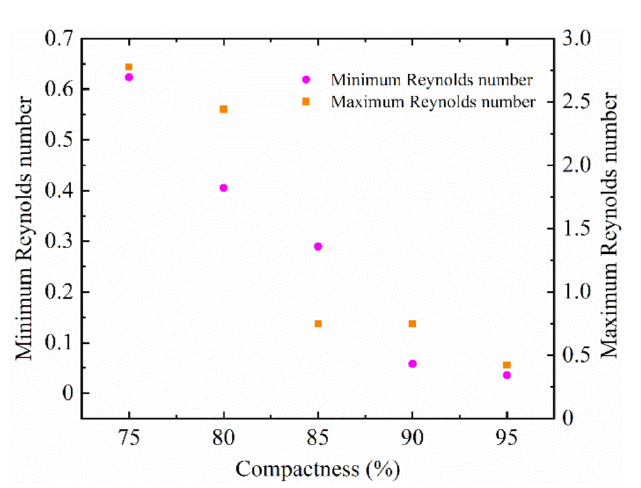
Figure 11. Minimum and maximum Rayleigh numbers of soil rock mixture with different